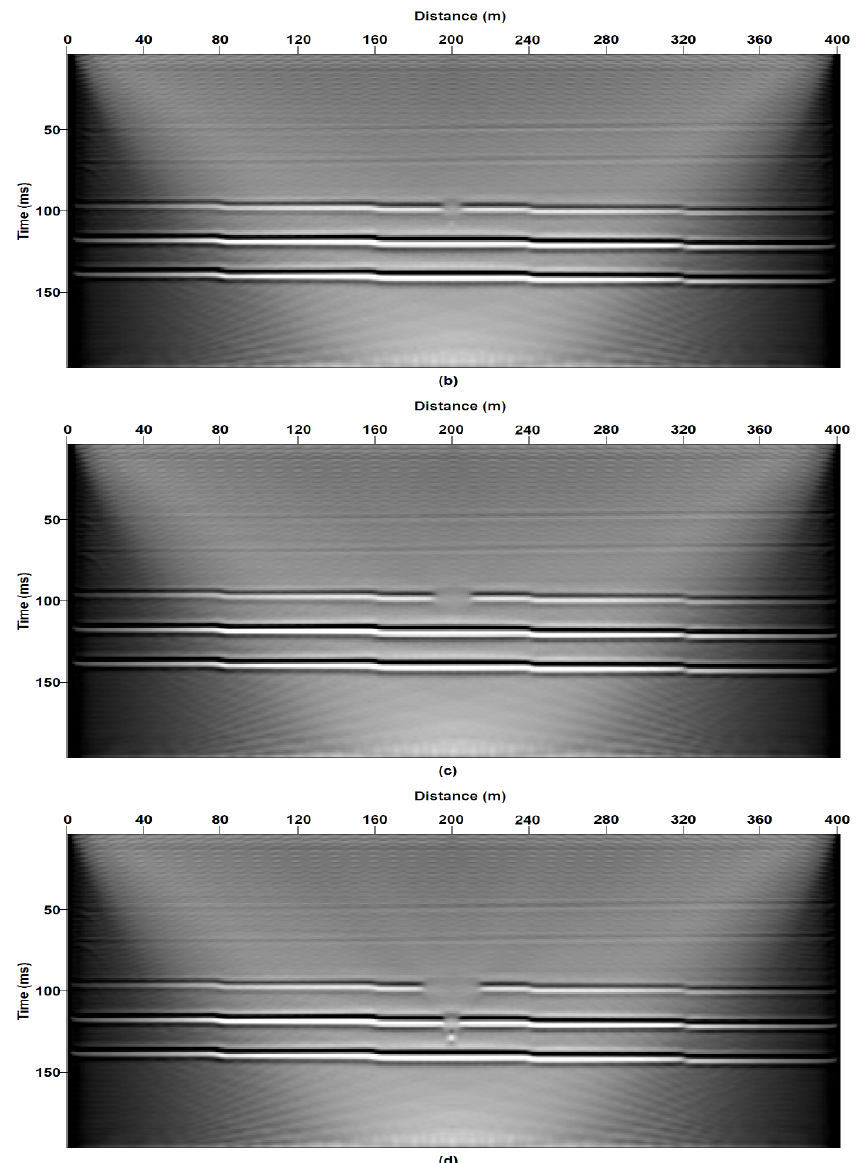
Figure 4. Numerical imaging results: ( a ) input velocity models of topographic variation (placed different size of depressions 10, 20 and 30 m in dotted red rectangle location) assuming the presence of a pockmark (triangle shape) on the seabed; RTM image of ( b ) small; ( c ) medium; and ( d ) large pockmarks.